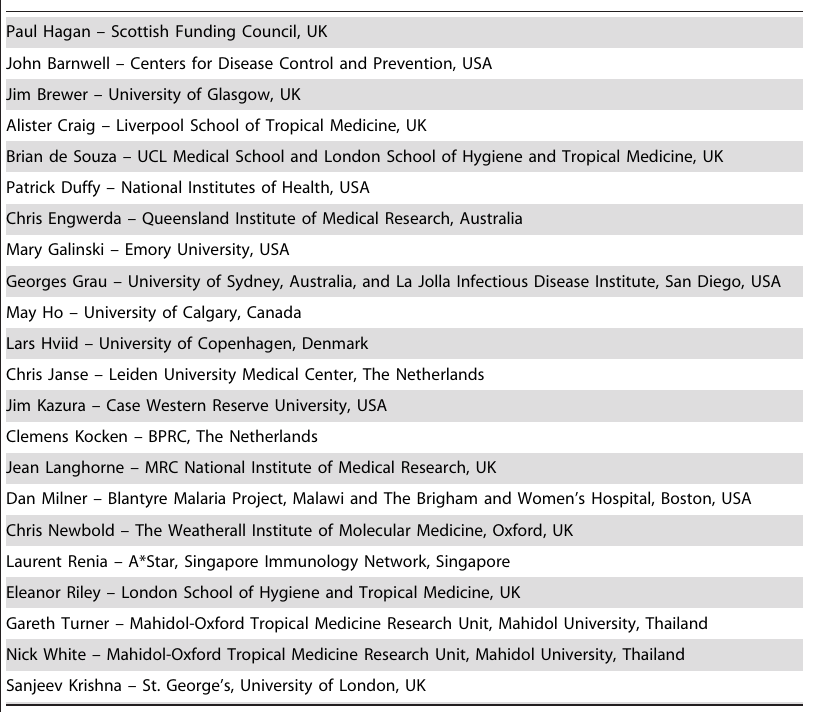
Table 1. Participants at the